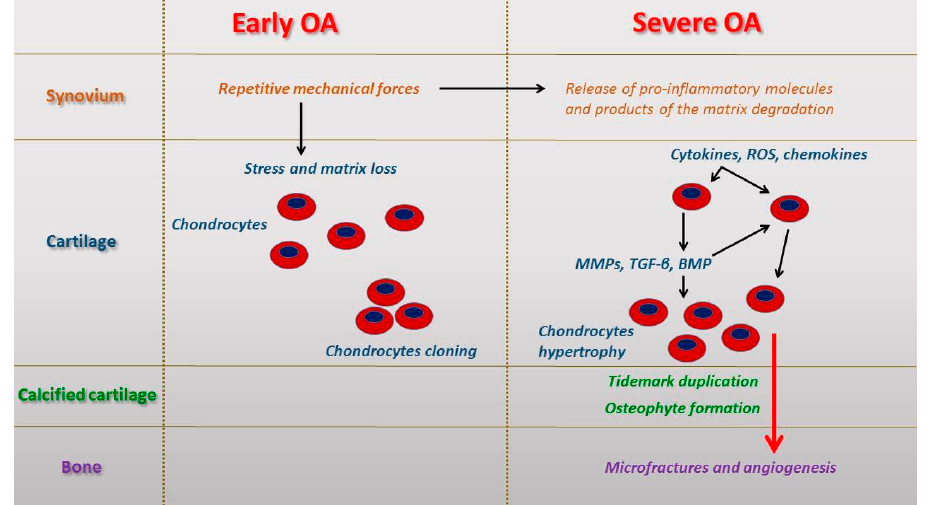
Figure 1. Early and severe osteoarthritis (OA) causes and molecular events in the different tissues involved in the joints. BMP: Bone morphogenetic proteins; MMPs: Matrix metalloproteinases; ROS: Reactive oxygen species; TGF- β : Transforming growth factor β